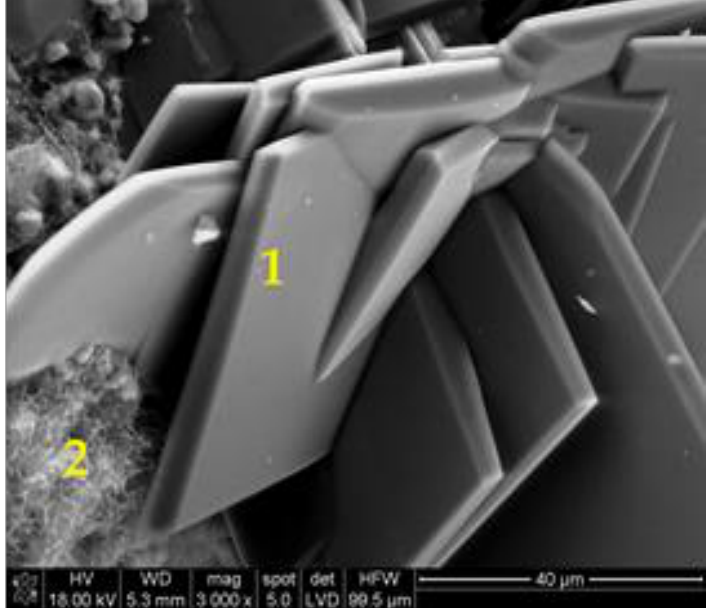
Figure 14. SEM image of traditional sand-lime bricks (containing Quartz Sand), SEM: high vaccum mode, 3000× magnification (1-C-S-H phase; 2-C-S-H crystallization towards tobermorite).